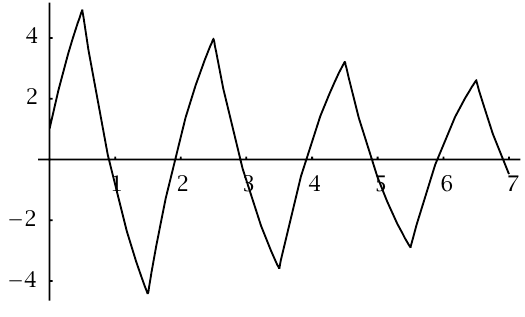
Figure 3.6 . T j (t) for b(t) = b , b = 1 . 1, j = 1, a = 1 /π